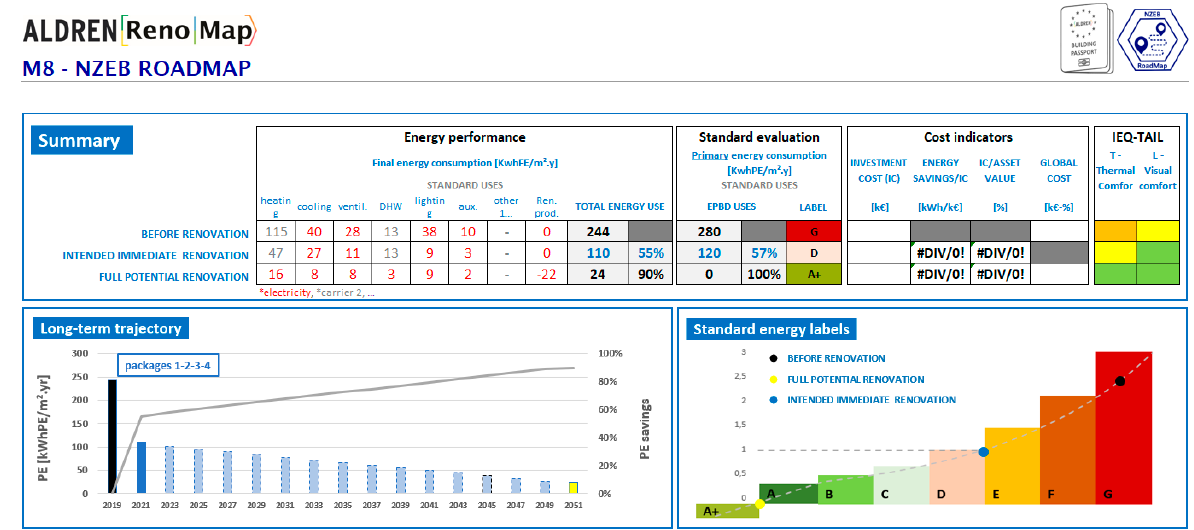
Figure 2. Summary part of the step-by-step ALDREN RenoMap template (values refer to a general example).